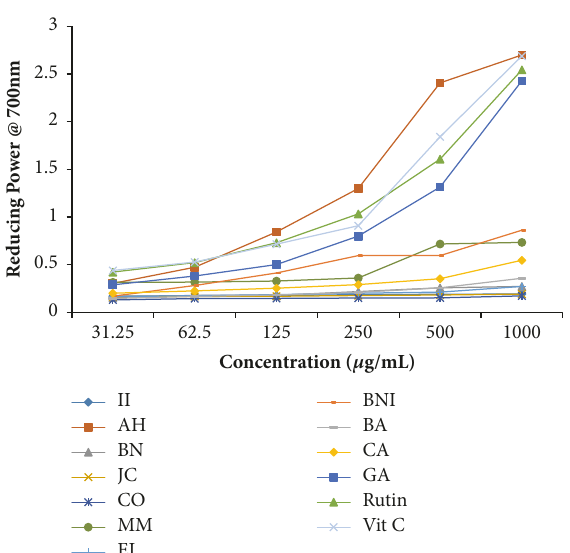
Figure 3: The ferric reducing antioxidative capacity of selected plant extracts used in the management of oral and skin infections in southeast folklore medicine of Nigeria. II, Ipomoea involucrata ; AH, Acalypha hispida ; BN, Breynia nivosa ; JC, Jatropha curcas ; CO, Chromolaena odorata ; MM, Macrolobium macrophyllum ; EI, Eleusine indica ; BNI, Baphia nitida ; BA, Burkea africana ; CA, Cassia alata ; GA, gallic acid; Vit C, vitamin C (standard antioxidants).